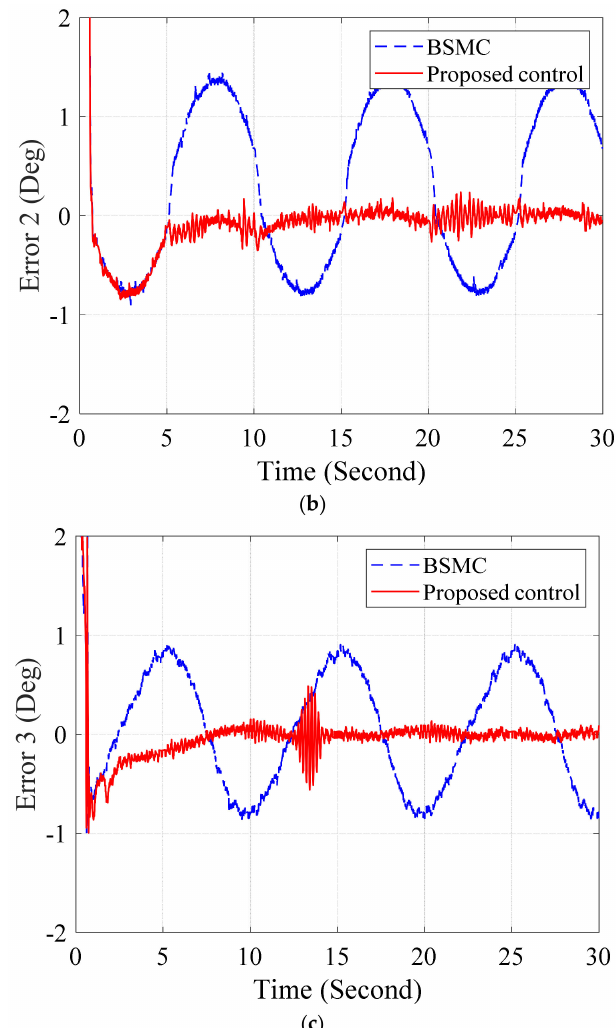
Figure 11. Error performance of BSMC and proposed control in ( a ) joint 1, ( b ) joint2, and ( c ) joint 3 without load.